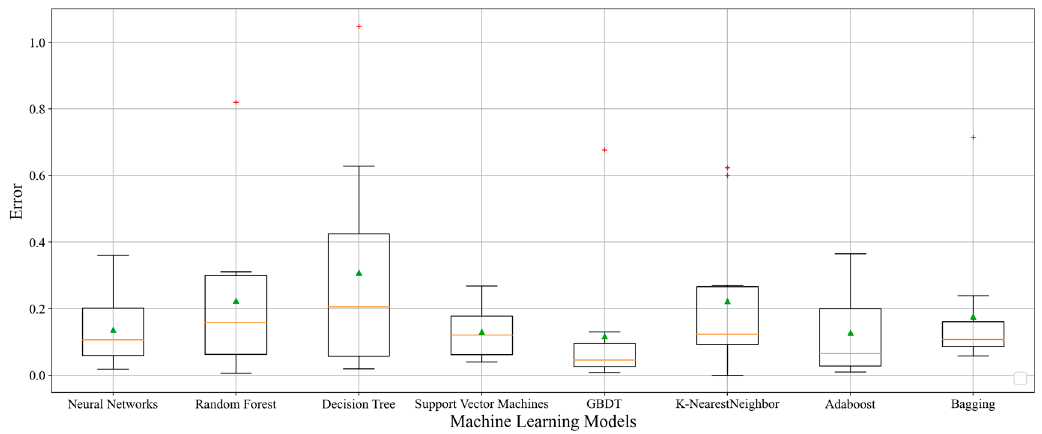
Figure 6. Results of the eight machine learning methods test set.